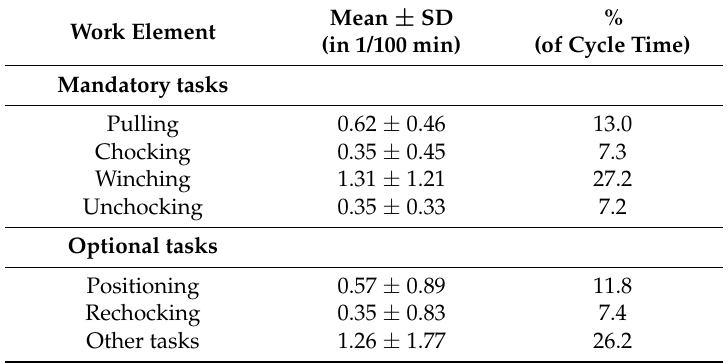
Table 5. Mean ( ± standard deviation) net time consumption of the work